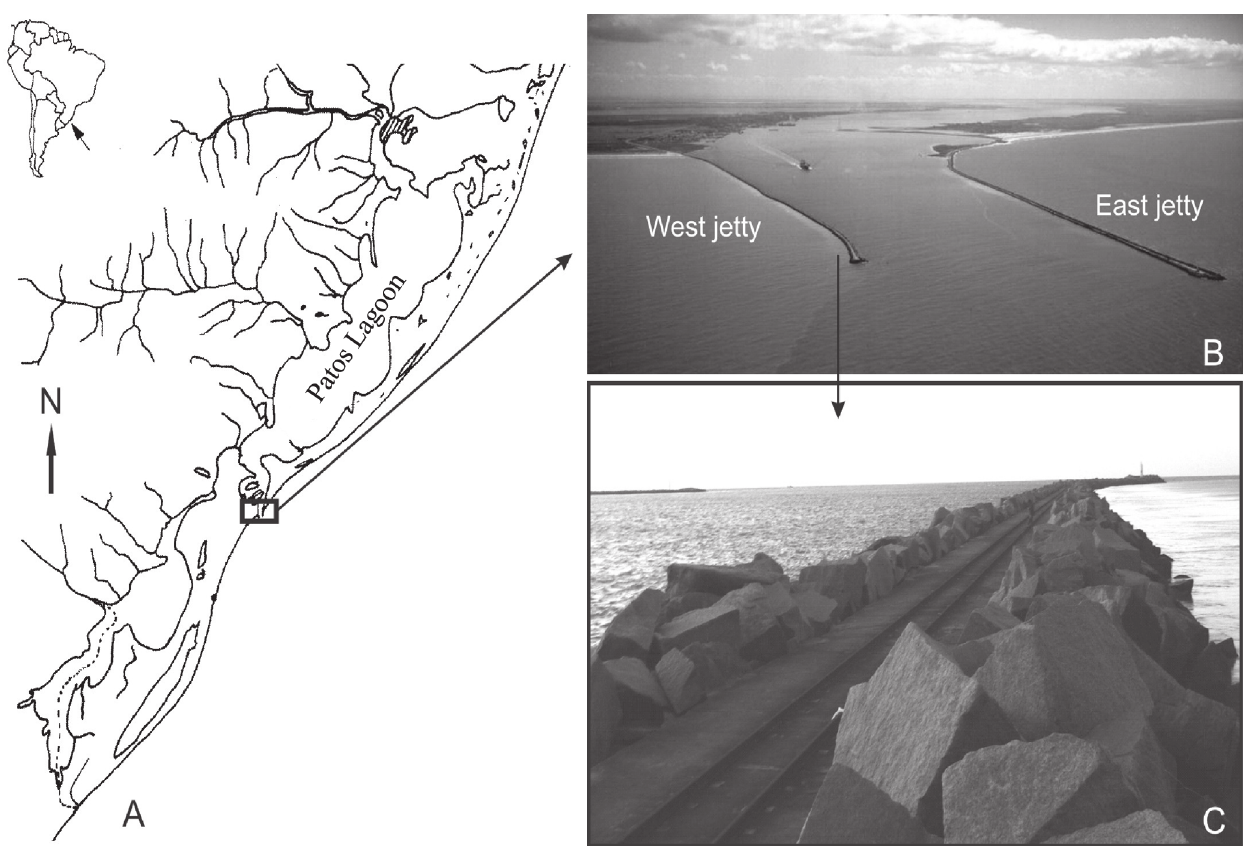
Fig. 1. Patos Lagoon (10.360 km 2 ) in southern Brazil ( A ) and the 4.5 km long pair of jetties that connects the estuarine zone of the lagoon with the Atlantic Ocean ( B ), detail of the west jetty and their large pieces of rock nearly 10 ton each ( C ). These rocky jetties are located in the Rio Grande City (Rio Grande do Sul State) in southern